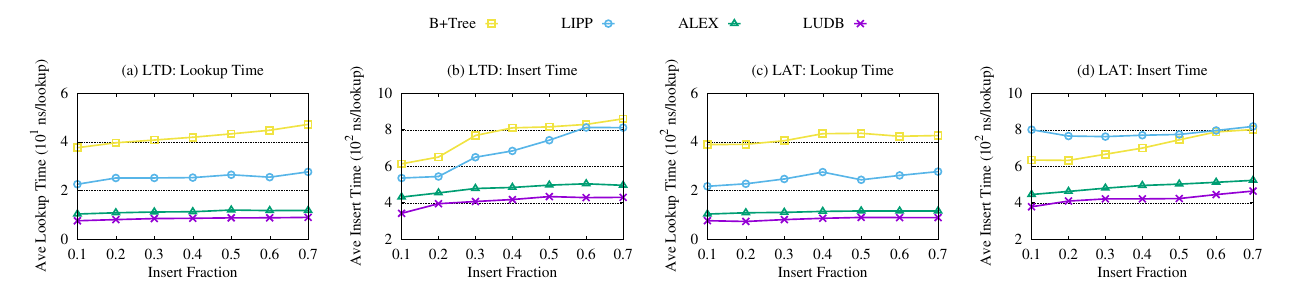
Figure 10. Lifetime